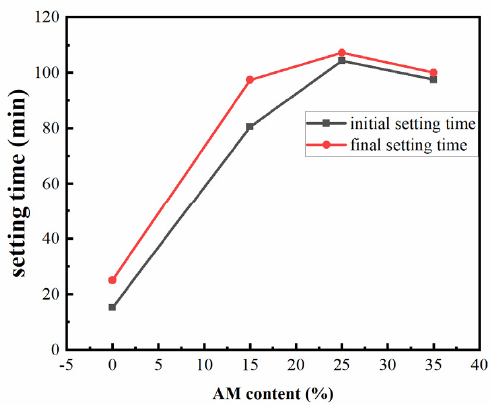
Figure 11. The effect of the AM content on the setting times of the paste.